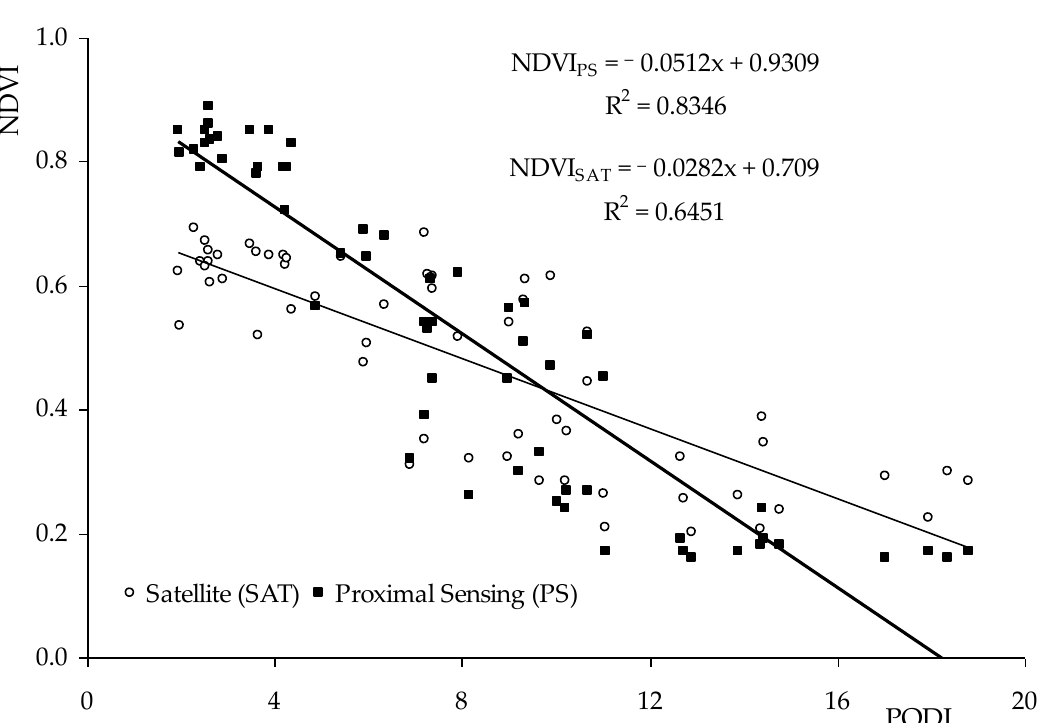
Figure 13. Correlation between NDVI values (obtained by proximal sensor, NDVI PS ; and by satellite, NDVI SAT ) and pasture quality degradation index (PQDI), in the set of monthly sampling dates (between February and June 2017).